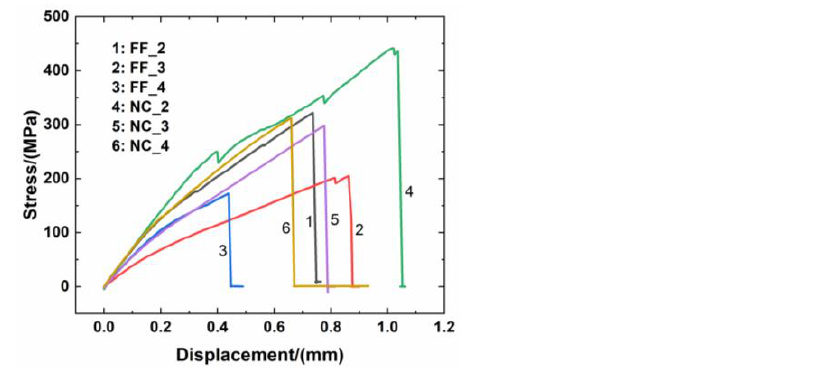
Figure 3. Load–displacement curves of C/SiC minicomposites with different interphase.